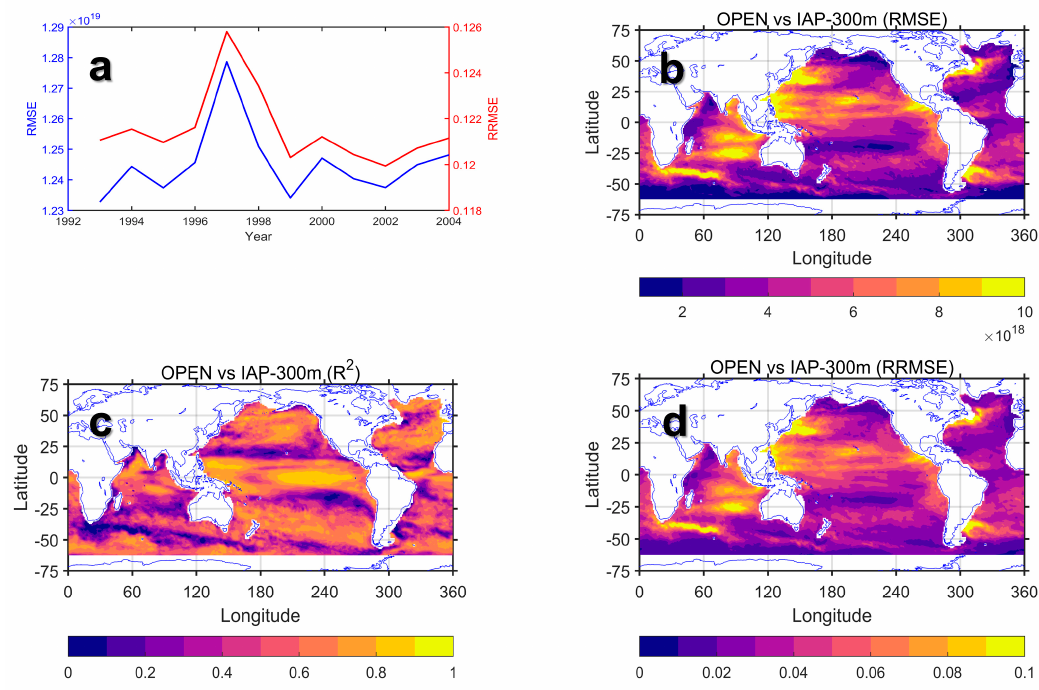
Figure 3. Hindcasted OPEN OHC300 accuracy against the Institute of Atmospheric Physics (IAP) summarized in ( a ) different years from 2014 to 2018; and in ( b,c , d ) spatial maps of temporal correlation ( c measured in R 2 ) and errors (measured in b RMSE and d RRMSE with respect to a universal value of standard deviation).